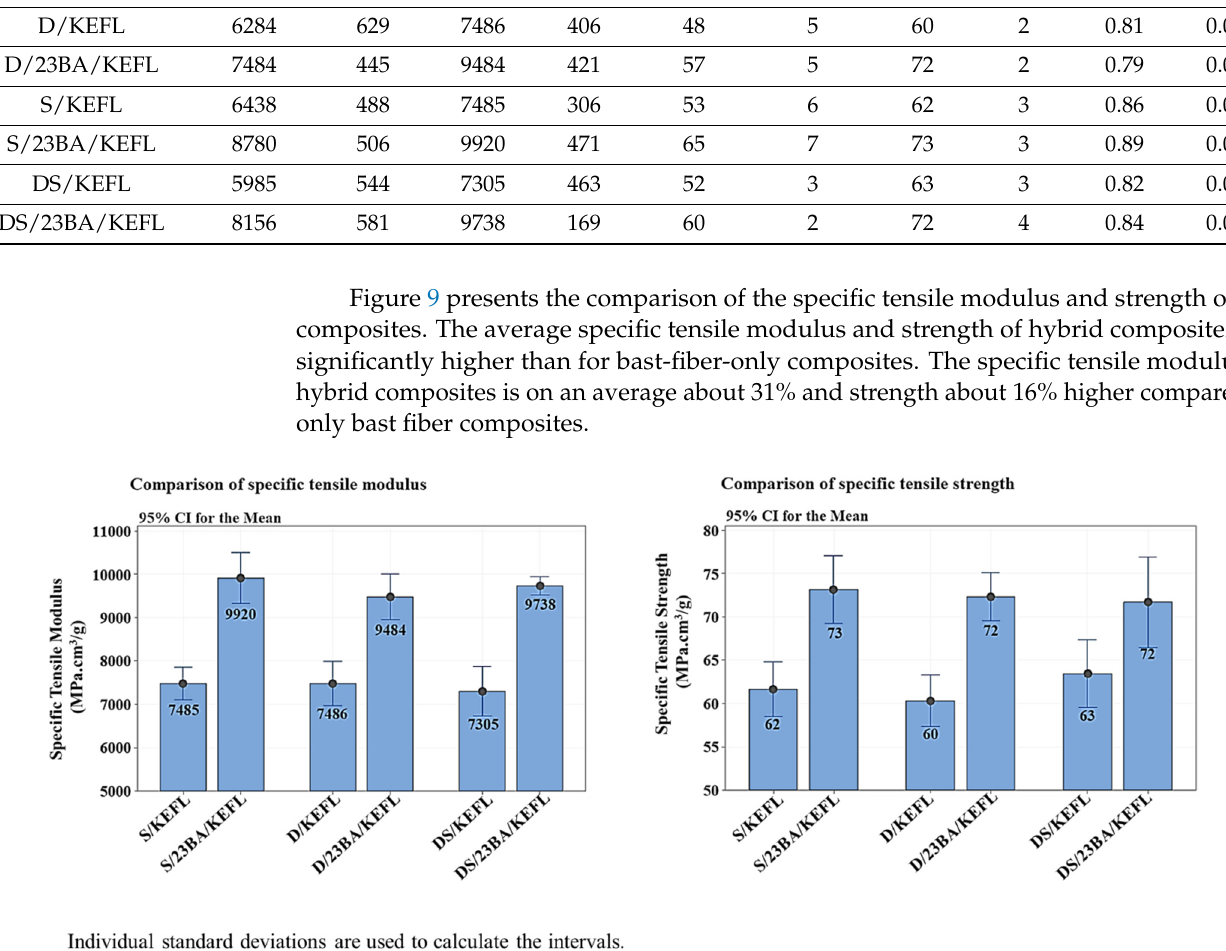
Table 8. Comparison of the equality of means using one way analysis of variance—specific tensile analysis.